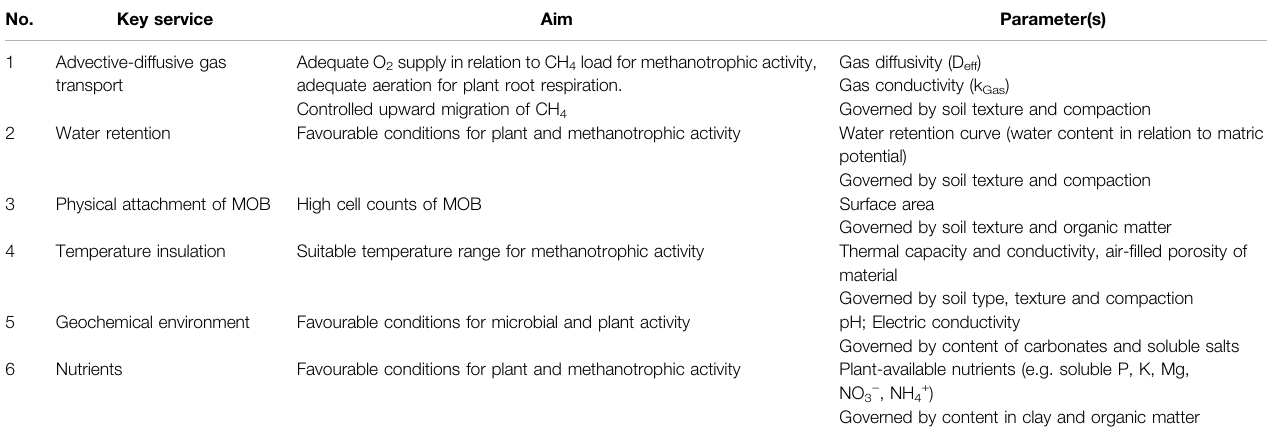
TABLE 1 | Summary of key services candidate MOL materials need to provide.